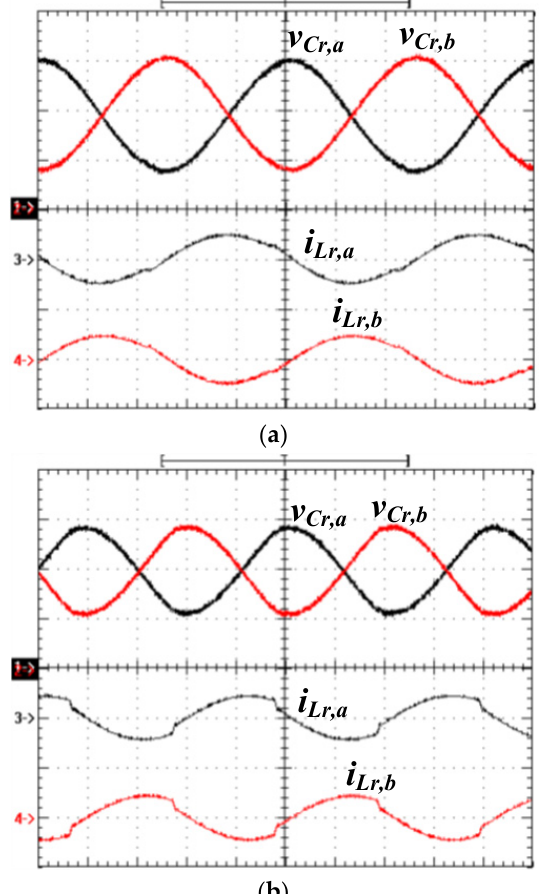
Figure 9. Experimental waveforms of v Cr,a , v Cr,b , i Lr,a and i Lr,b at 100% rated power under ( a ) V in = 750 V ( v Cr,a , v Cr,b : 100 V/div; i Lr,a , i Lr,b : 10 A/div; time: 2 µ s) and ( b ) V in = 800 V ( v Cr,a , v Cr,b : 100 V/div; i Lr,a , i Lr,b : 10 A/div; time: 2 µ s).